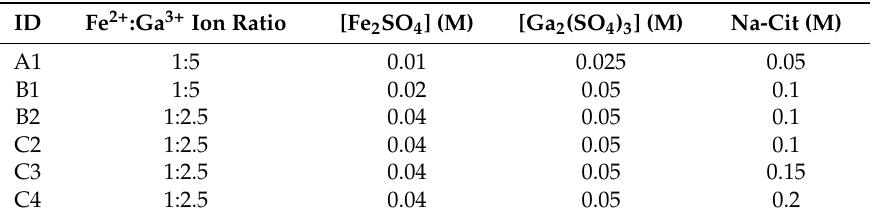
Table 1. Electrolytes used in combinatorial study.